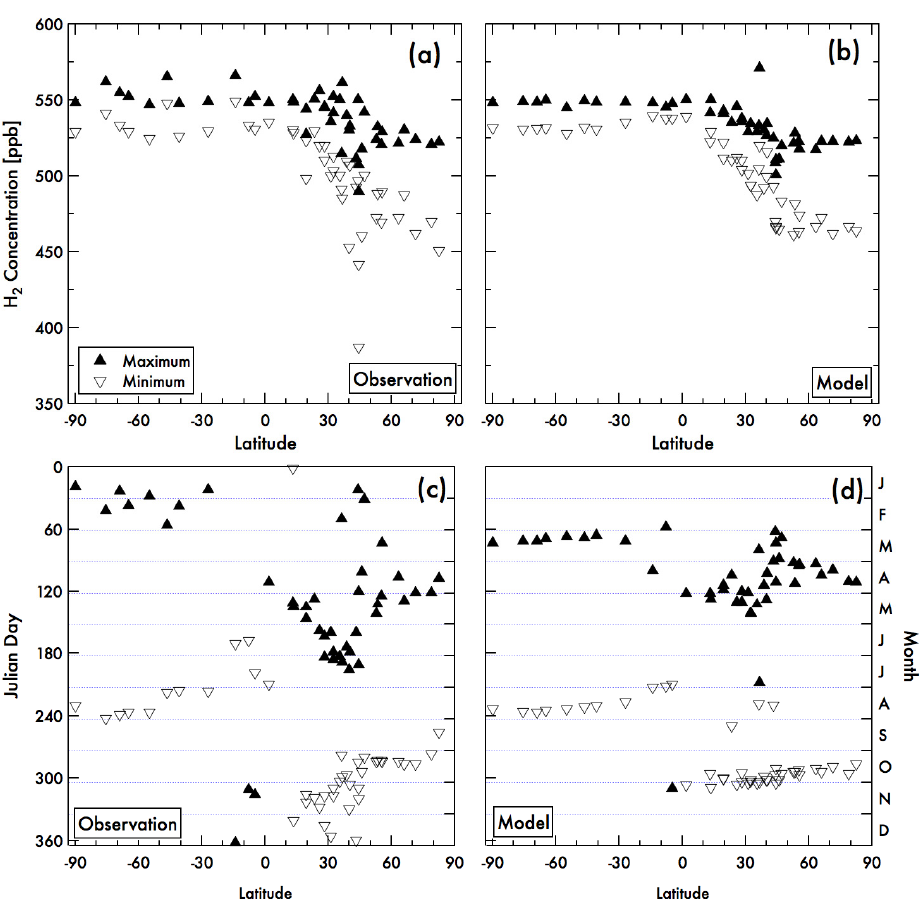
Fig. 5. Latitudinal distribution of the seasonal maximum (closed triangle) and minimum (open triangle) for H 2 mixing ratio (upper panel, a , b ) and for the occurrence date (lower panel, c , d ). The values obtained from the observations are shown in panels (a) and (c) and from the model simulation (b, d).